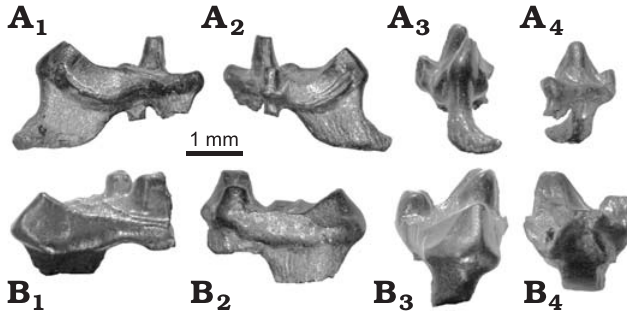
Fig. 5. Normal light photographs of studied specimens of eutherian mam- mal teeth from the Berriasian Purbeck Group of Dorset, southern England; in mesial (A 1 , B 1 ), distal (A 2 , B 2 ), lingual (A 3 , B 3 ), and labial (A 4 , B 4 ) views. A . Durlstotherium newmani gen. et sp. nov., NHMUK PV M 99991. B . Durlstodon ensomi gen. et sp. nov., NHMUK PV M